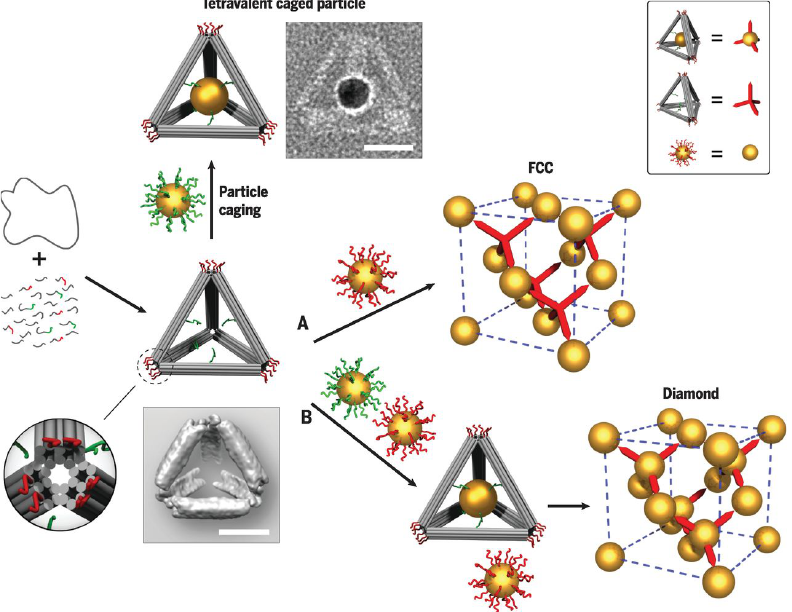
Figure 8. Illustration of how to generate tetrahedron origami cages with two sets of sticky ends: green one acting as an anchor to encapsulate and hold the nano-particles and the red ones acting as sticky patch to bind with basis particles. ( A , B ) represent two routes of assembly, resulting into FCC and diamond structures, respectively. Reprinted from [80], with permission from